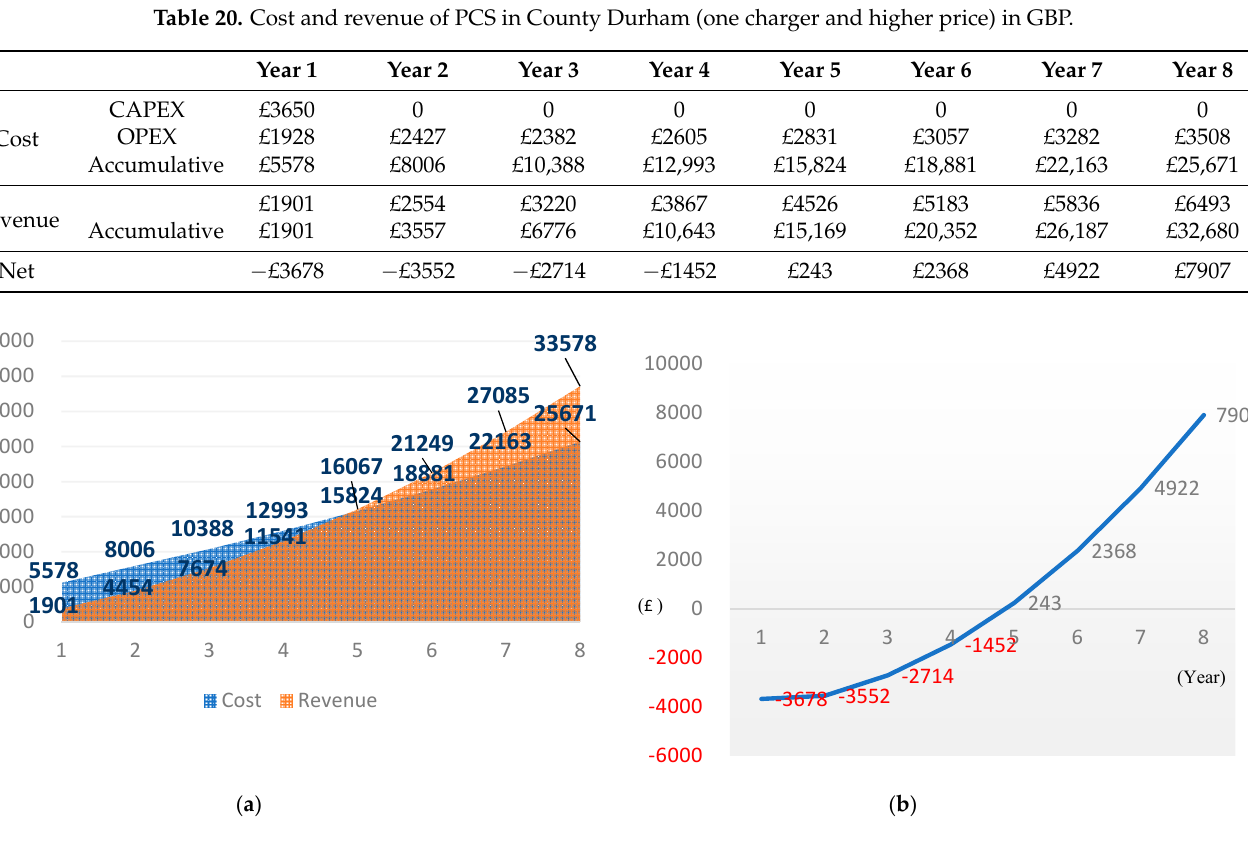
Figure 13. ( a , b ) Revenue analysis (one charger and higher price). Table 20. Cost and revenue of PCS in County Durham (one charger and higher price) in GBP.